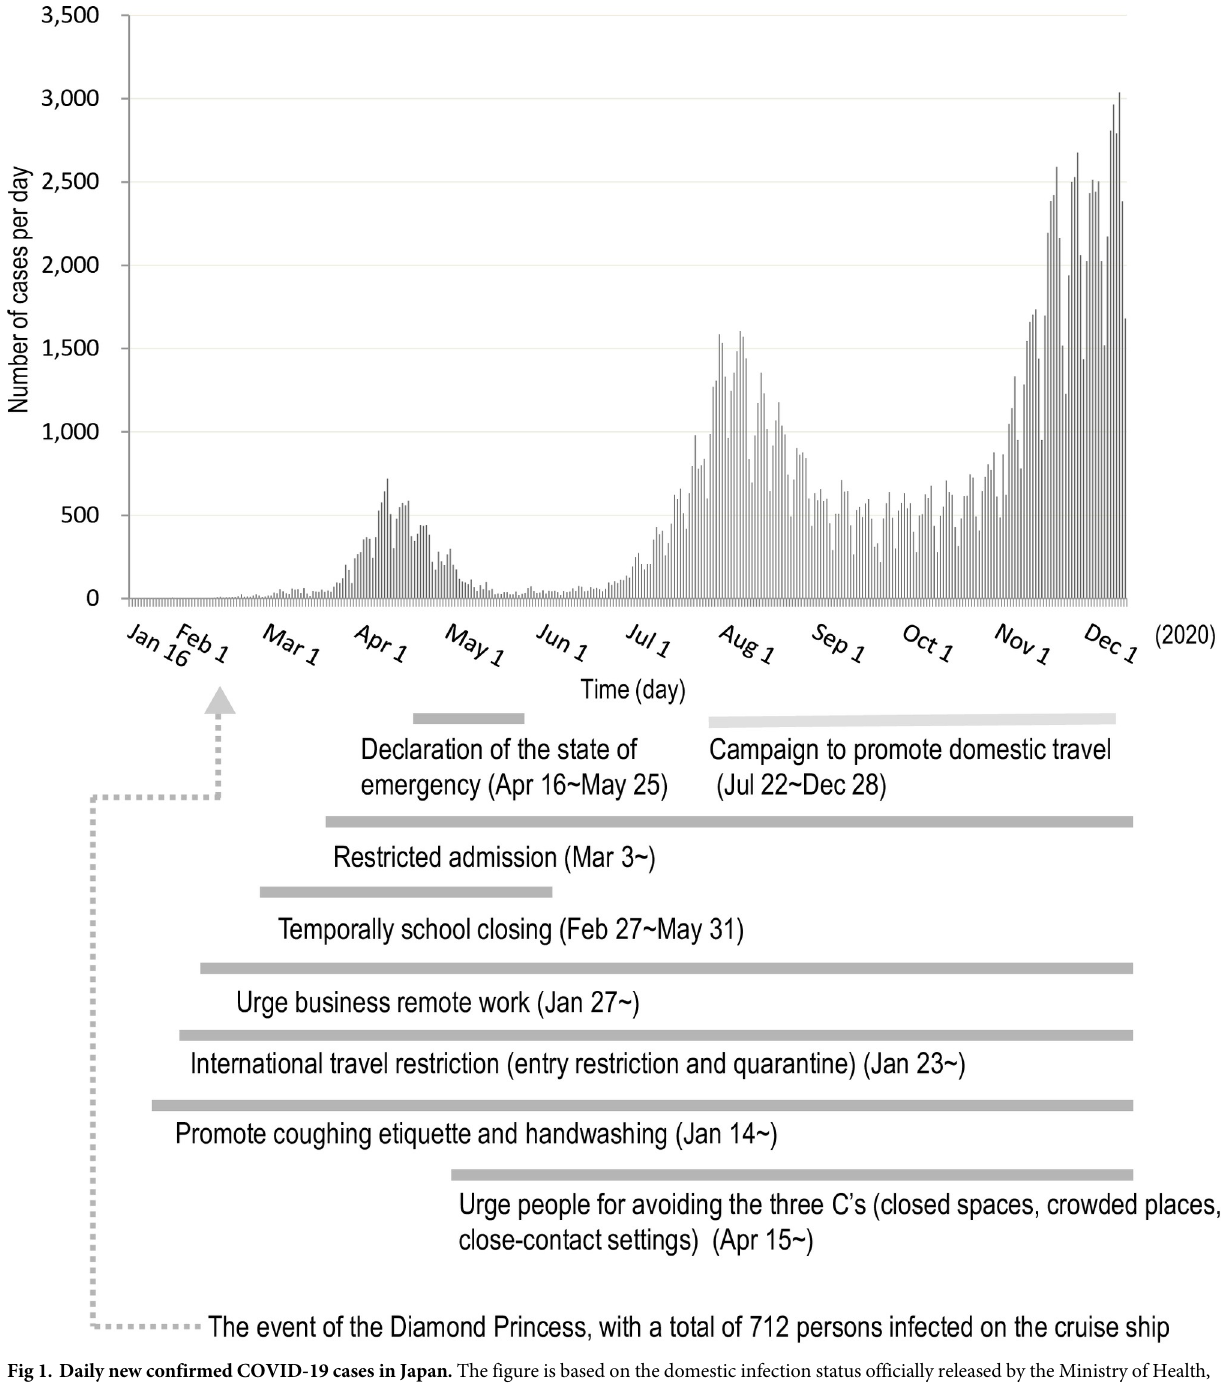
Fig 1. Daily new confirmed COVID-19 cases in Japan. The figure is based on the domestic infection status officially released by the Ministry of Health, Labour and Welfare in Japan [7].